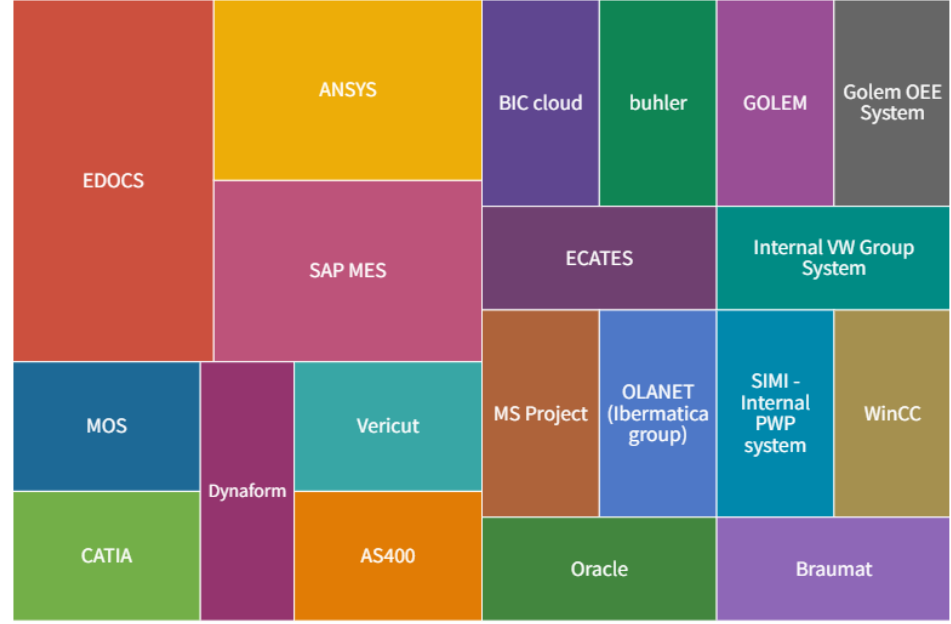
Figure 12. MES systems implemented in the companies.